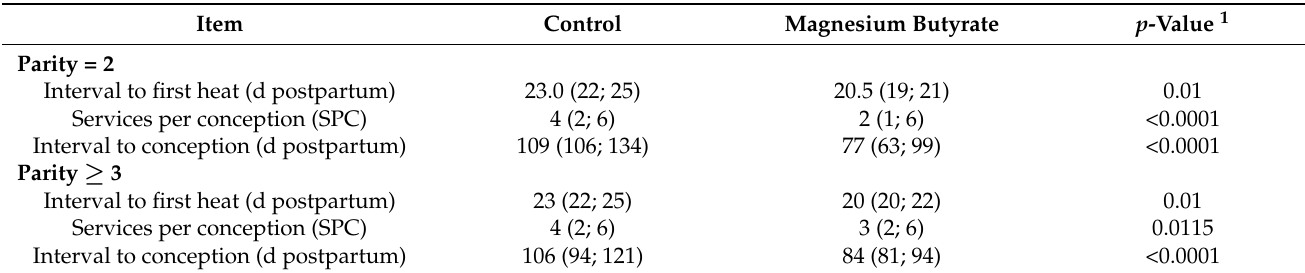
Table 4. Median (and 95%CI for intervals, min-max for SPC) of parameters related to fertility of Control ( n = 112) and Magnesium butyrate ( n = 107) cows.